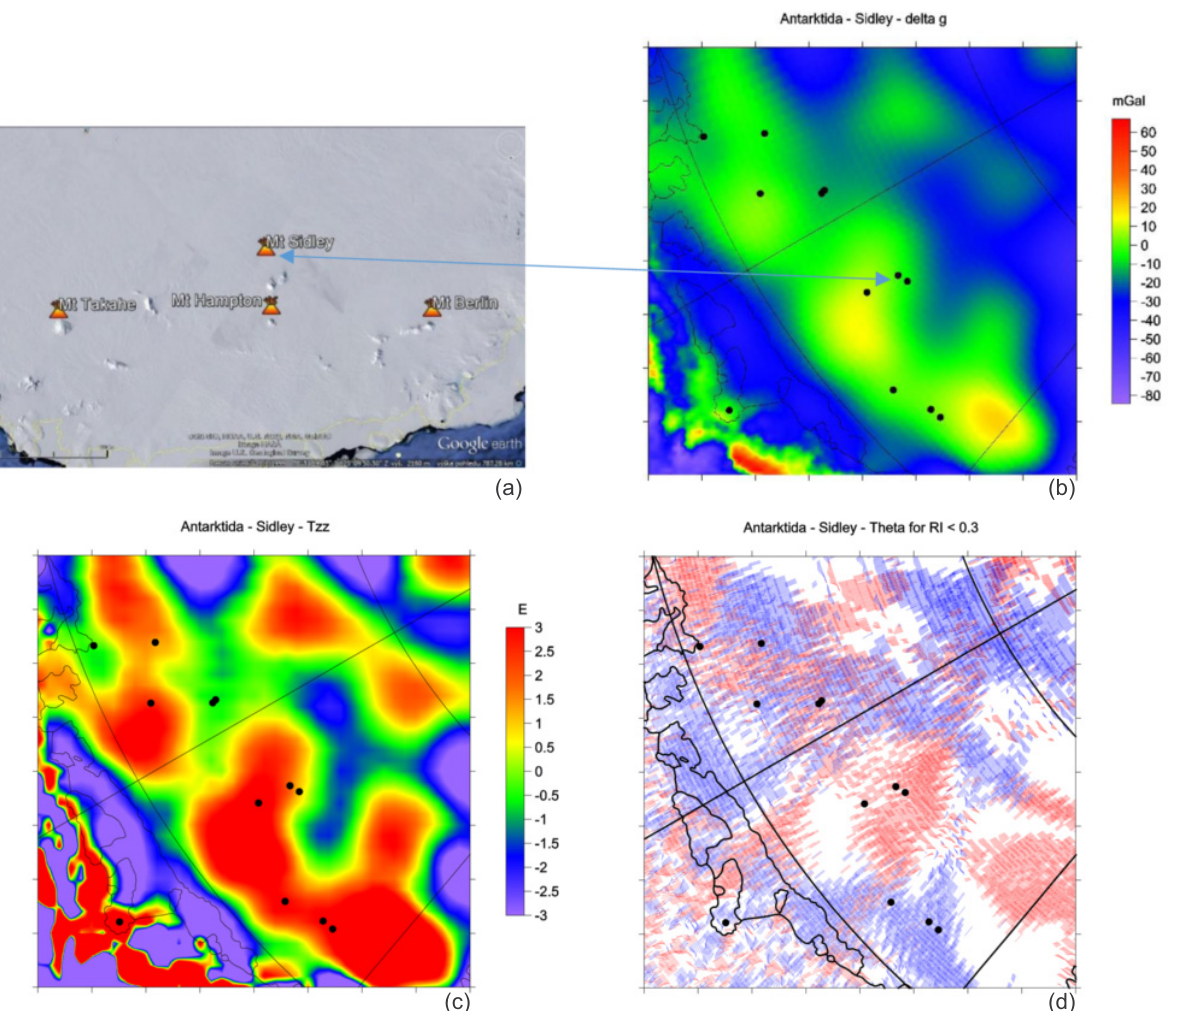
, (d) i (for I < 0.3). (Figure continues on next zz